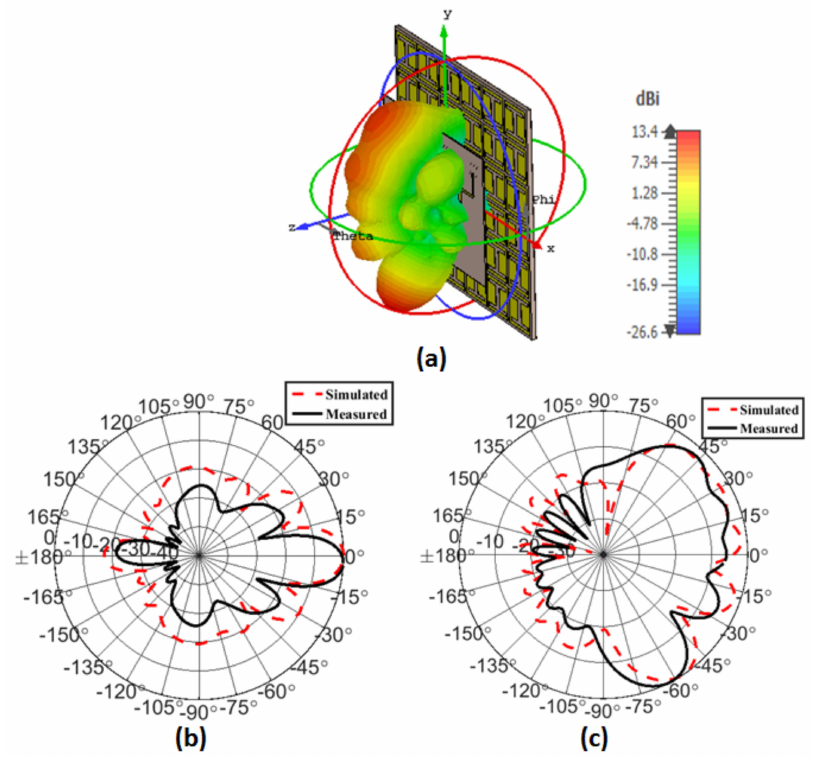
Figure 17. The radiation pattern of the 1 × 4 antenna array at 28 GHz; ( a ) 3D, ( b ) normalized pattern in XZ-plane, and ( c ) normalized pattern in